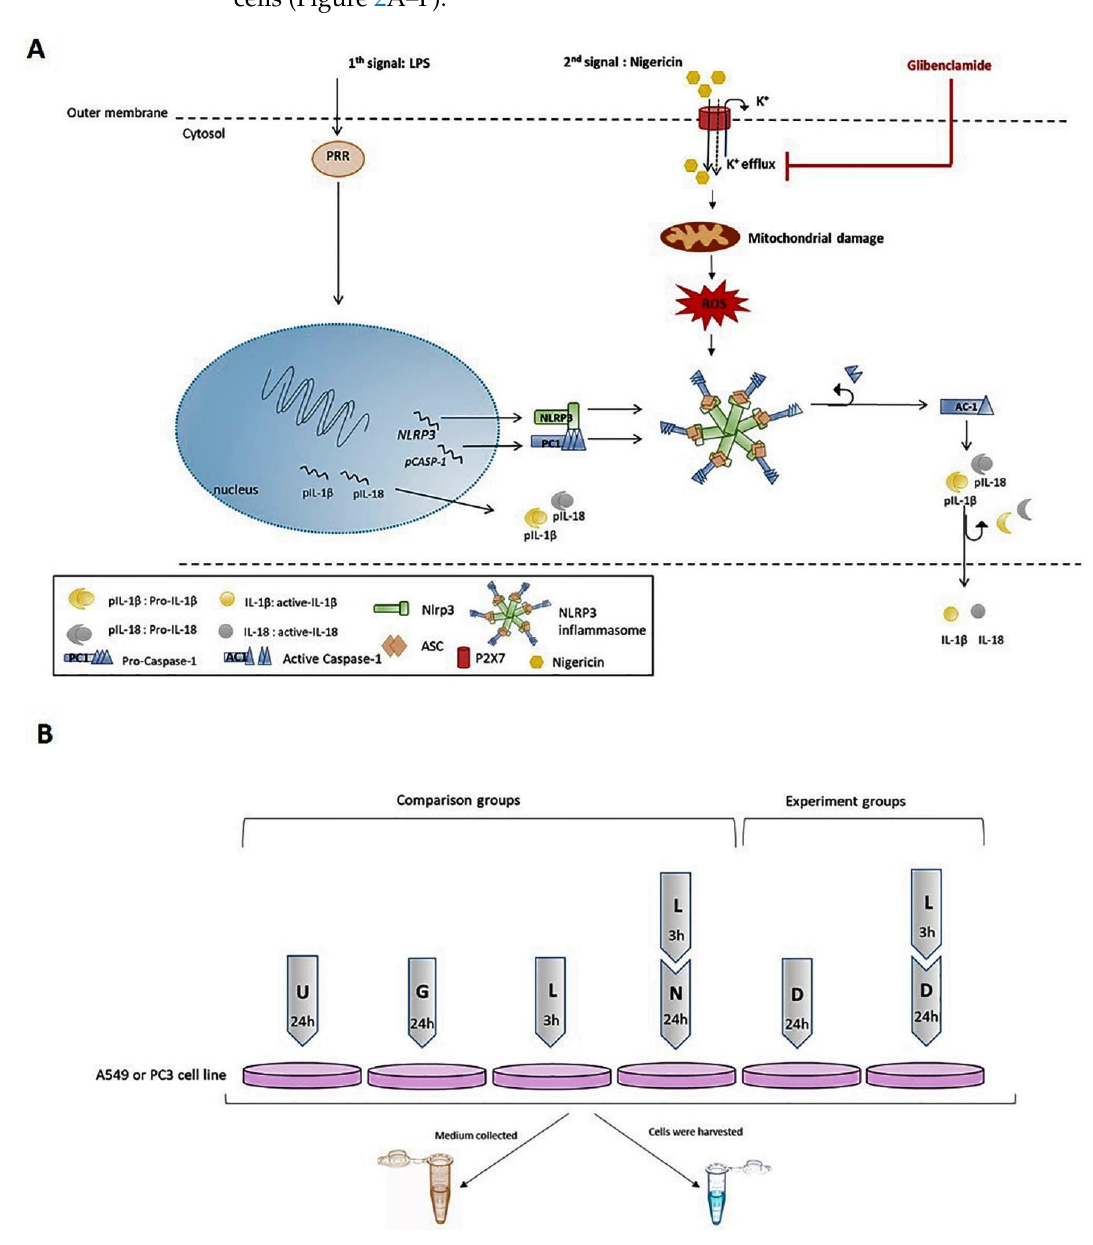
Figure 1. The experimental design. ( A ) The effect of LPS, Nigericin and Glibenclamide on NLRP3 activation. LPS as the signal 1 is a priming trigger inducing the NLRP3 and pro-IL-1β production. Nigericin is the signal 2 and plays role in polymerization of an active NLRP3 inflammasome complex which recruits pro-Caspase-1 and cleaved it to active form of Caspase-1. The Caspase-1 liberates functional IL-1β and IL-18, regulatory cytokines of inflammation. Glibenclamide is a potassium channel inhibitor and blocks the polymerization of NLRP3 protein complex. ( B ) The experimental control groups consisted of: 1. A549 and PC3 cells treated with glibenclamide for 24 h as the positive control of NLRP3 inhibition; 2. LPS-only for 3 h as the positive control of NLRP3 priming; 3. LPS+nigericin treatment for 24 h as the positive control of active NLRP3 inflammasome complex. The experimental test groups consisted of A549 and PC3 cells treated with doxycy- cline-only for 24 h and pretreated with LPS for 3 h. U: Untreated PC3 or A549 cells, G: Glibenclamide, L: LPS, N: Nigericin, D: Doxycycline, PRR: The cytosolic pattern recognition receptor, AC1: Active Caspase-1, PC1: Pro-Caspase-1, ASC: Apop- tosis-associated speck-like protein containing a CARD, ROS: reactive oxygen species.